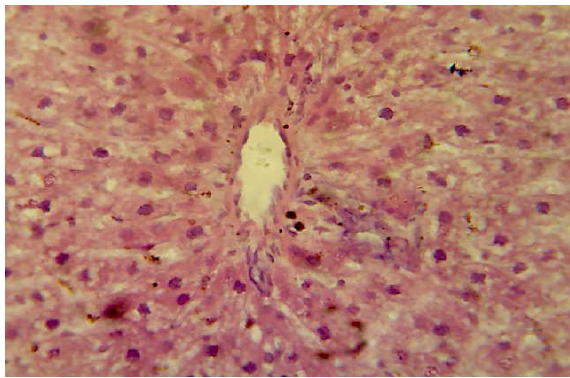
Figure, 11. In section of histopathology in the liver of animal receiving 1mg/kg B.W. of acrylamide and 250mg/kg B.W betaine for 65 days in (G4 group): showed normal structure (H.& E.stain 400X).